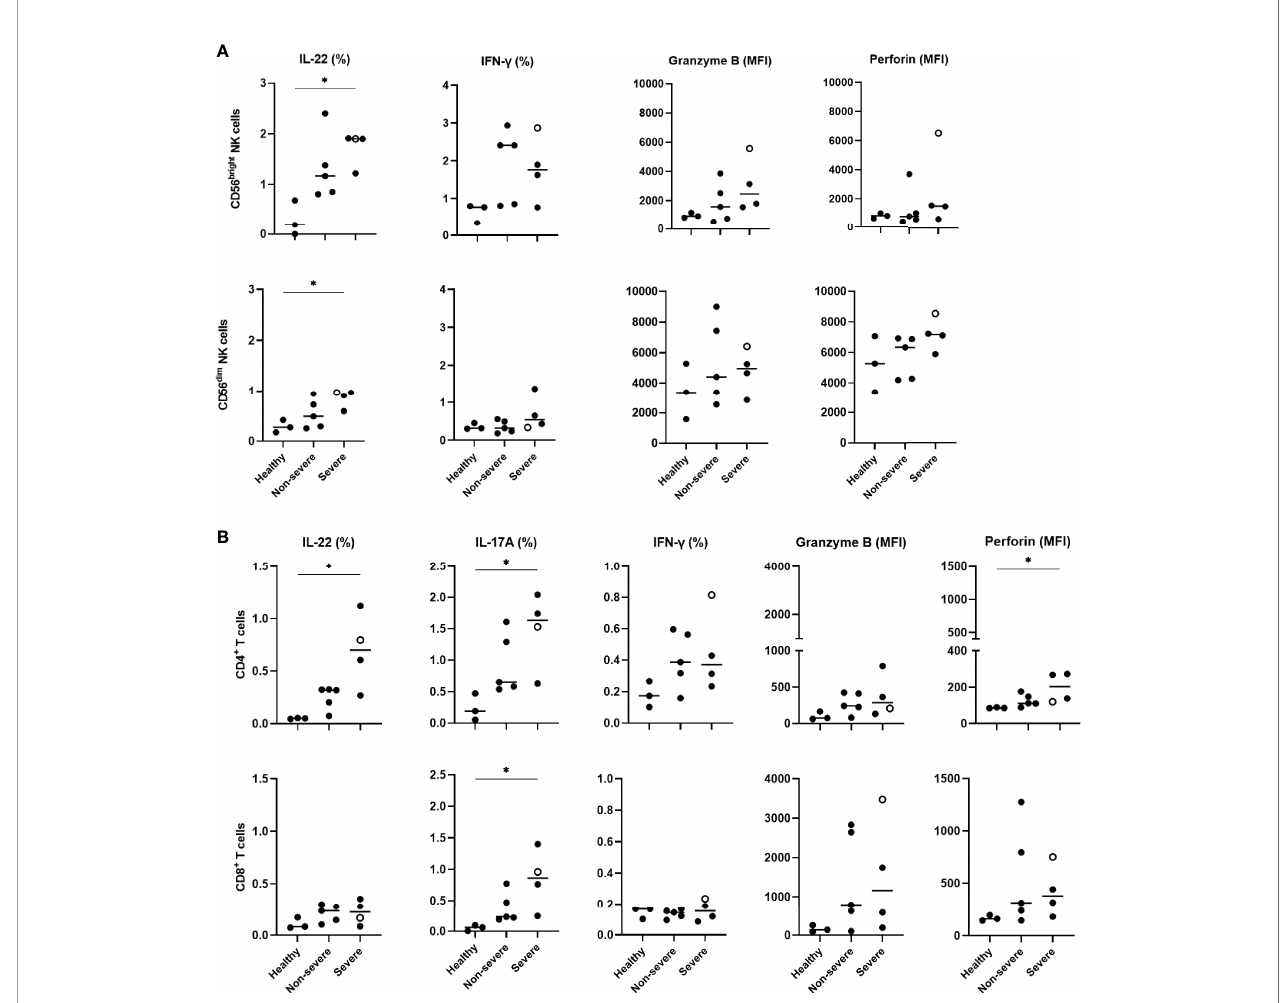
FIGURE 7 | Cytokine expressions and cytotoxicity mediators of peripheral blood NK and T cells in COVID-19 patients compared to healthy controls. (A) IL-22, IFN- g , granzyme B and perforin expressions on CD56 bright and CD56 dim NK cells, (B) IL-22, IL-17A, IFN- g , granzyme B and perforin expressions on CD4 + and CD8 + lymphocytes, are shown according to study groups (3 healthy controls, 5 non-severe and 4 severe patients). PBMC were left unstimulated in supplemented RPMI medium during 24 hours before staining them with the different monoclonal antibodies to identify the IL-22, IL-17A, IFN- g , granzyme B and perforin content of CD56 bright and CD56 dim NK cells, CD4 + and CD8 + lymphocytes. Results of cytokine content are indicated as percentages of cytokine-containing cells whereas those of granzyme B and perforin are indicated as the MFI of the subset-containing cells. The patient who died from COVID-19 is represented by an empty circle. The horizontal bars indicate the medians of the results within each column. Non-paired data were analyzed by the Kruskal Wallis test, and the signi fi cant p values are indicated as * p